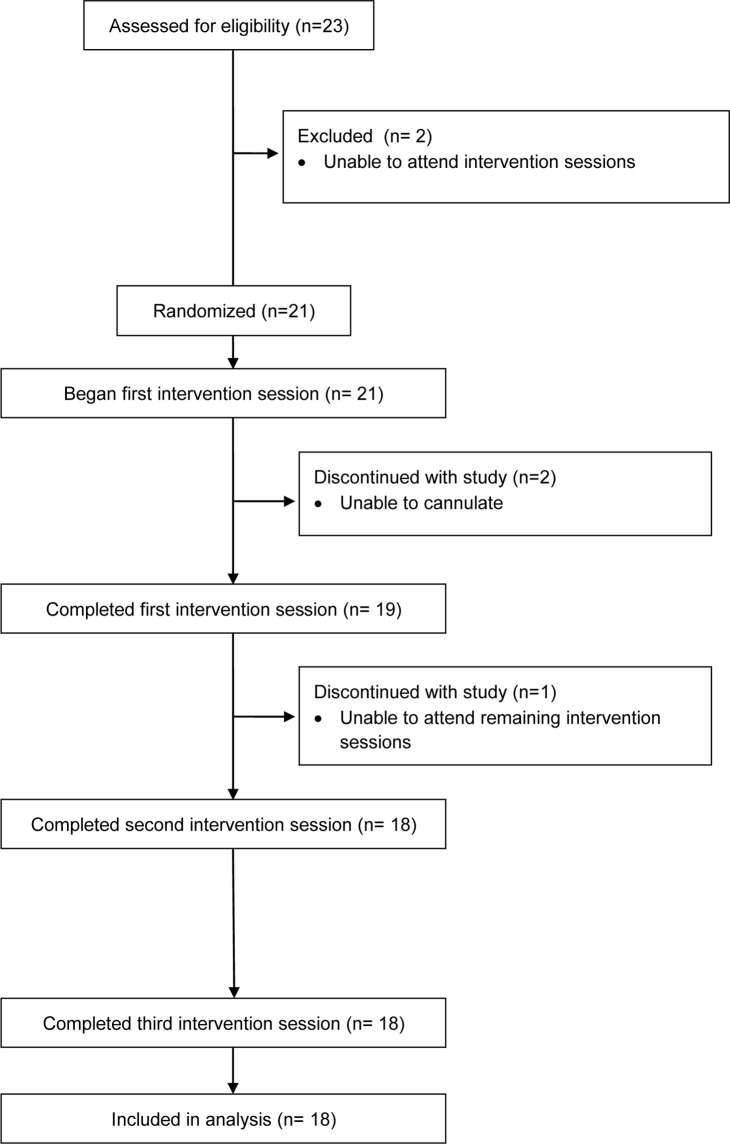
Participant flow diagram (CONSORT).